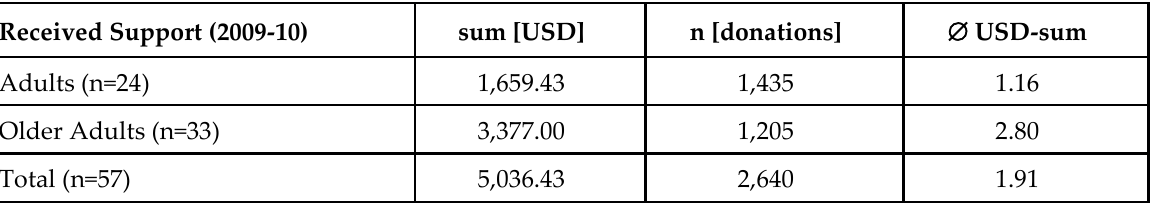
Table 3: Received Financial and/or Material Support: Difference Adults-Elderly during One Year